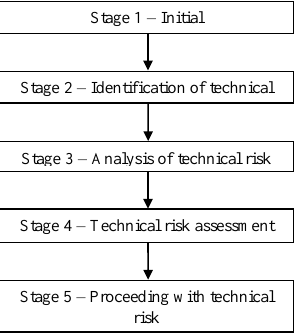
Figure 1: Methodology of technical risk assessment in a manufactur- ing